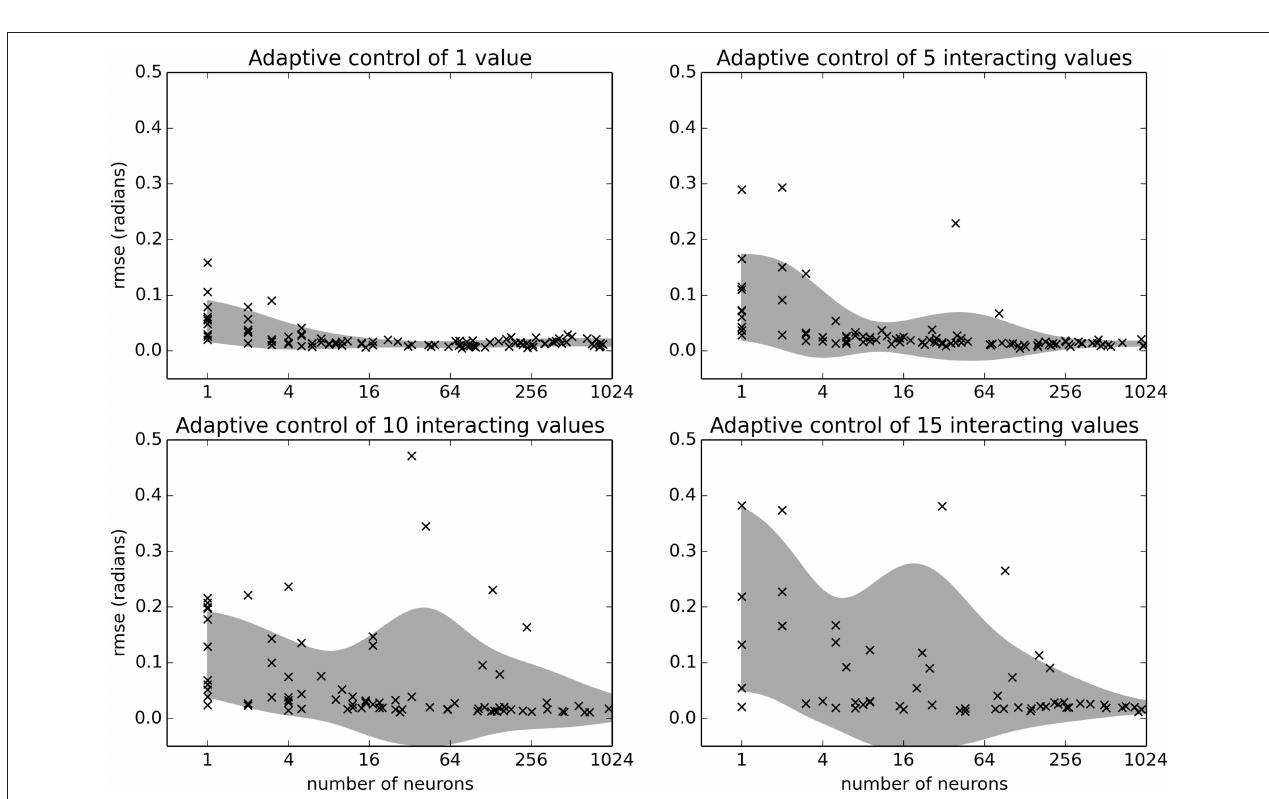
FIGURE 9 | Benchmark results examining the relationship between number of neurons and the number of simulated joints N . The benchmark was run on the Intel i5-3337U CPU. Shaded area is the mean plus or minus one standard deviation, smoothed with a Gaussian kernel of σ = 1 in the log 2 domain. As shown in Figure 9 , adapting for unknown interacting quality of the control is thus dependent on how good an forces on 15 joints is possible with 500 neurons. This gives an approximation the neurons can make of this complex non-linear indication of how many neurons are needed for different function.